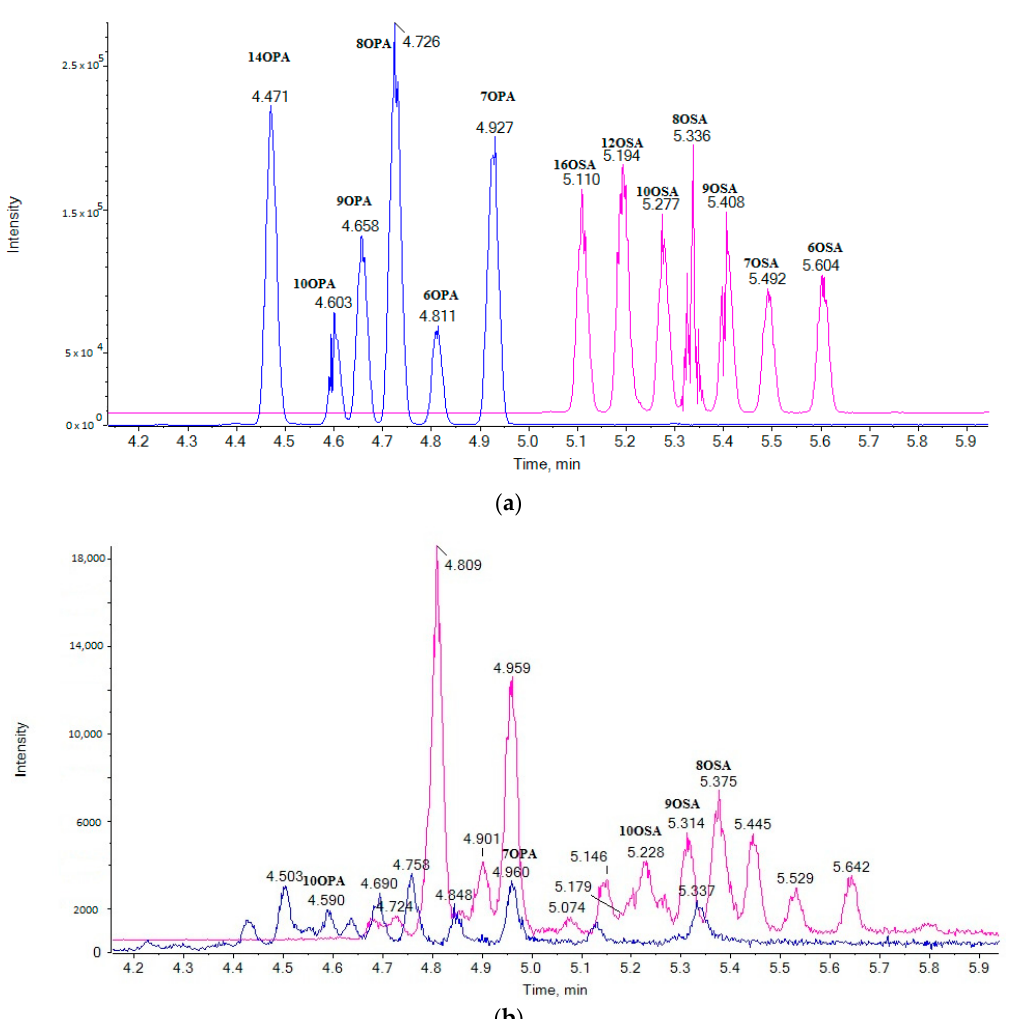
Figure 1. Extracted ion chromatograms (EICs) of oxopalmitic acids (OPAs) (blue line, exact mass m/z 269.2122) and oxostearic acids (OSAs) (magenta line, exact mass m/z 297.2435) in a standard solution (0.5 μ g/mL) ( a ) and in a representative cow milk sample ( b ).